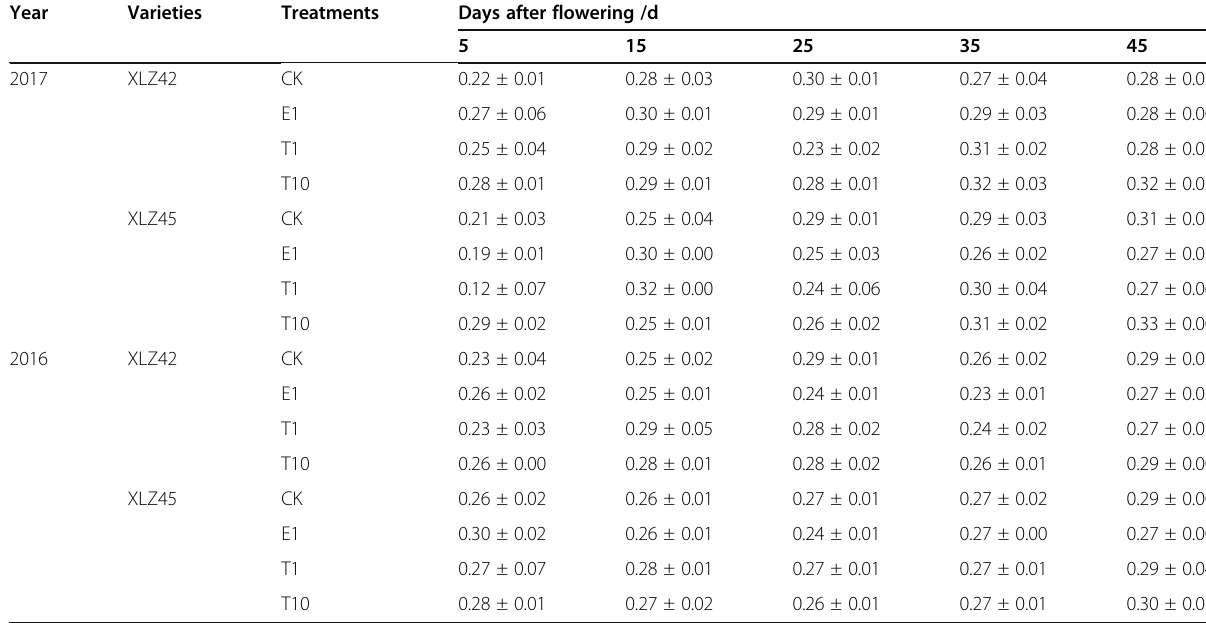
Table 4 The initial slope of the fast light curve ( α , electrons photons − 1 ) of two cotton varieties (XLZ42 and XLZ45) at different days after flowering in various treatment groups: Mulch film was removed at 1 and 10 days before the first irrigation (respectively T1(June 20, 2017)) after seedling emergence, during 2016 – 2017. The control group (CK) had film mulching throughout the growth stages. Values are means ± standard deviation (n = 3)